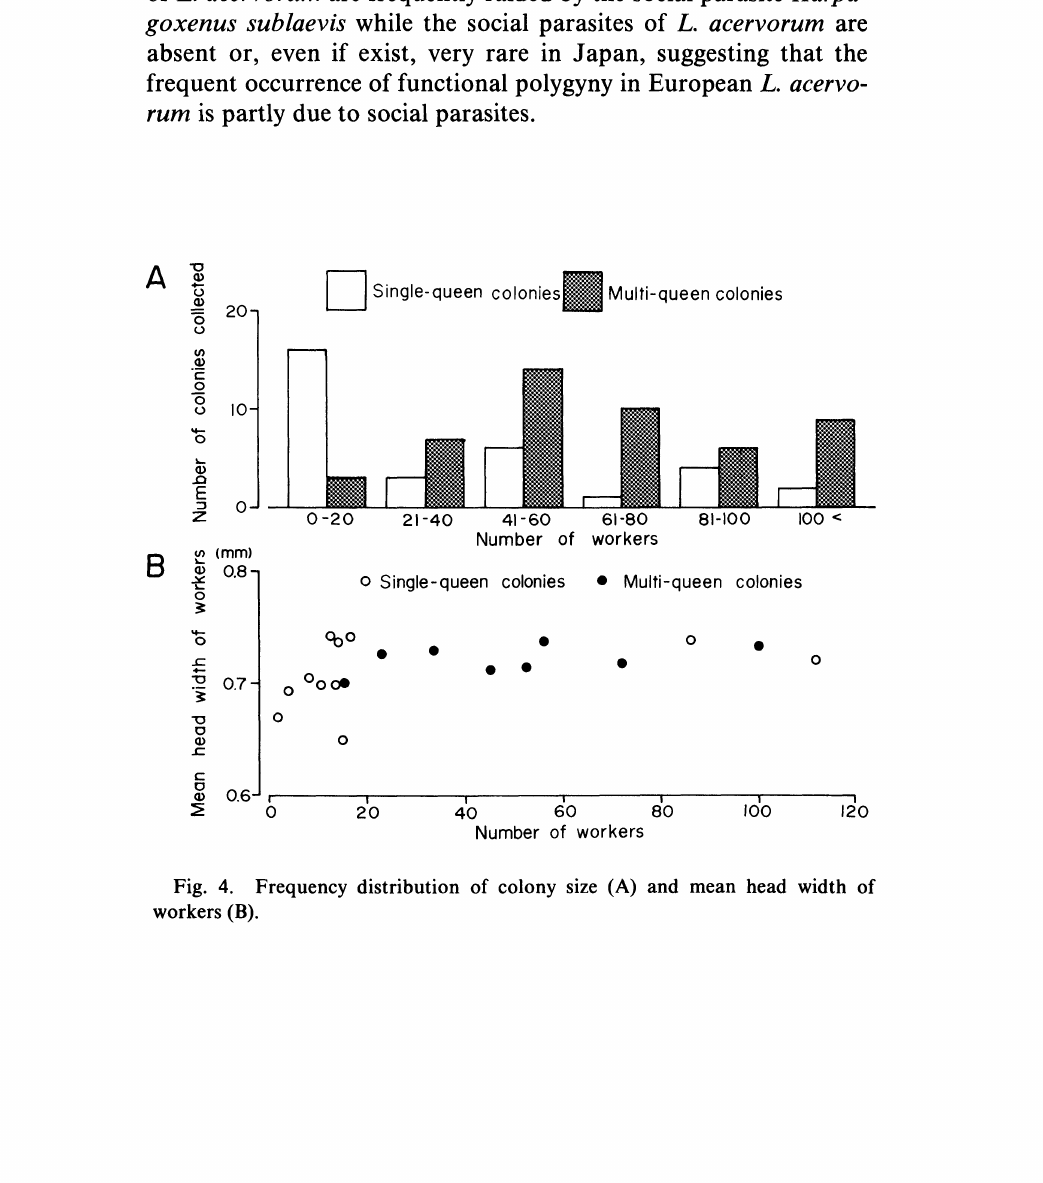
Fig. 4. Frequency distribution of colony size (A) and mean head width of workers